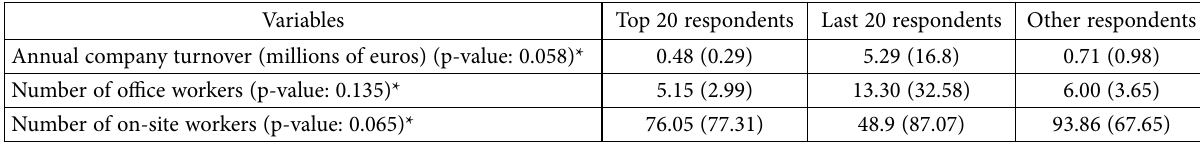
Table 6. Verification of non-response bias in sampling (ANOVA analysis)